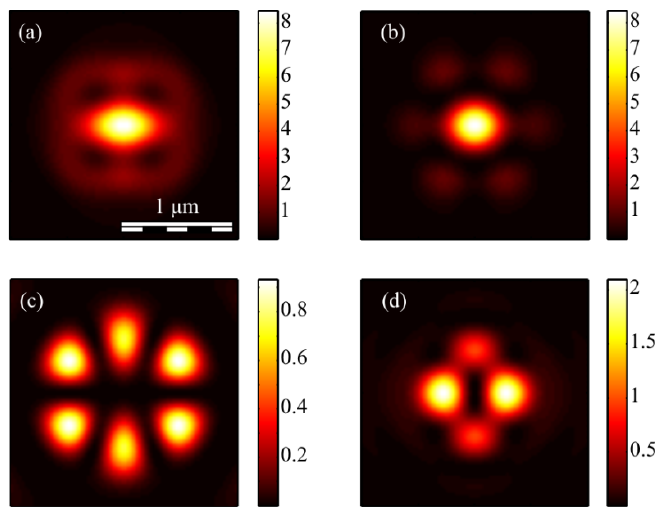
Figure 5. The intensity I ( a ) and its components I x ( b ), I y ( c ) I z ( d ) of the focused vector field (1) of the second ( m = 2) order with a = 3/2.